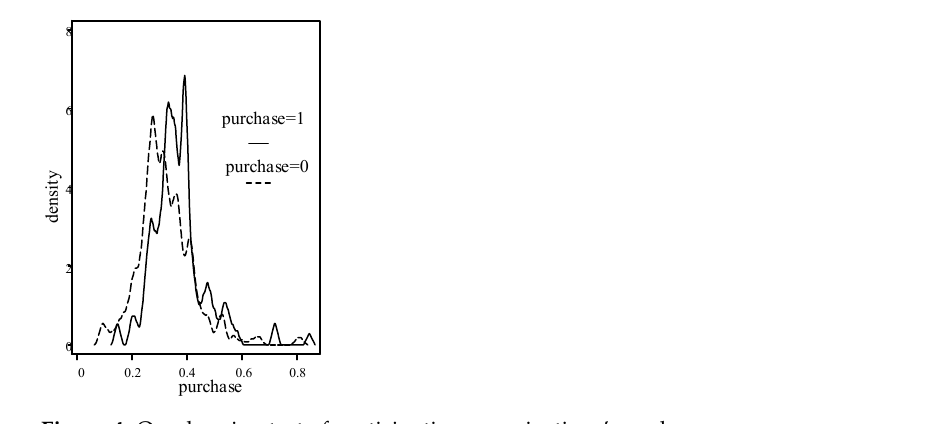
Figure 3. Overlapping test of participating in training.